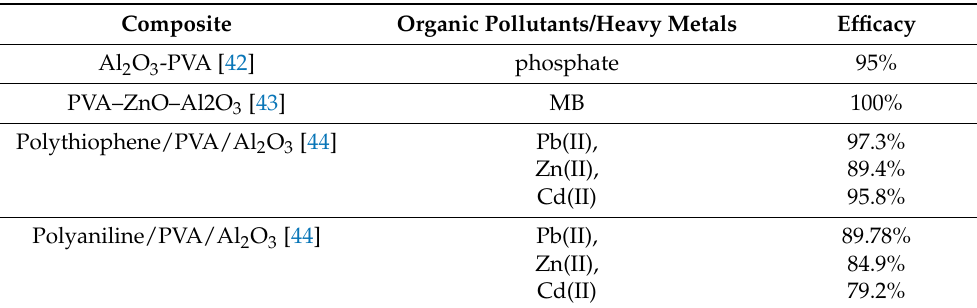
Table 1. Recent survey of nanocomposite based on Al 2 O 3 -PVA for removal heavy metals or degrada- tion of organic